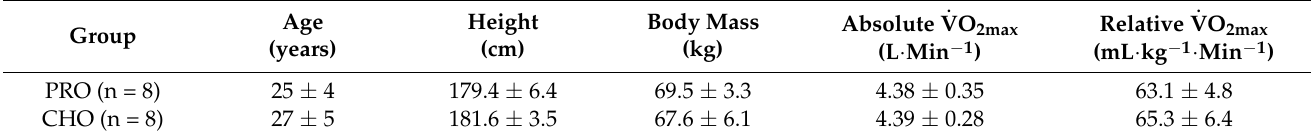
Table 1. Baseline participant characteristics according to allocated starting group (mean ±